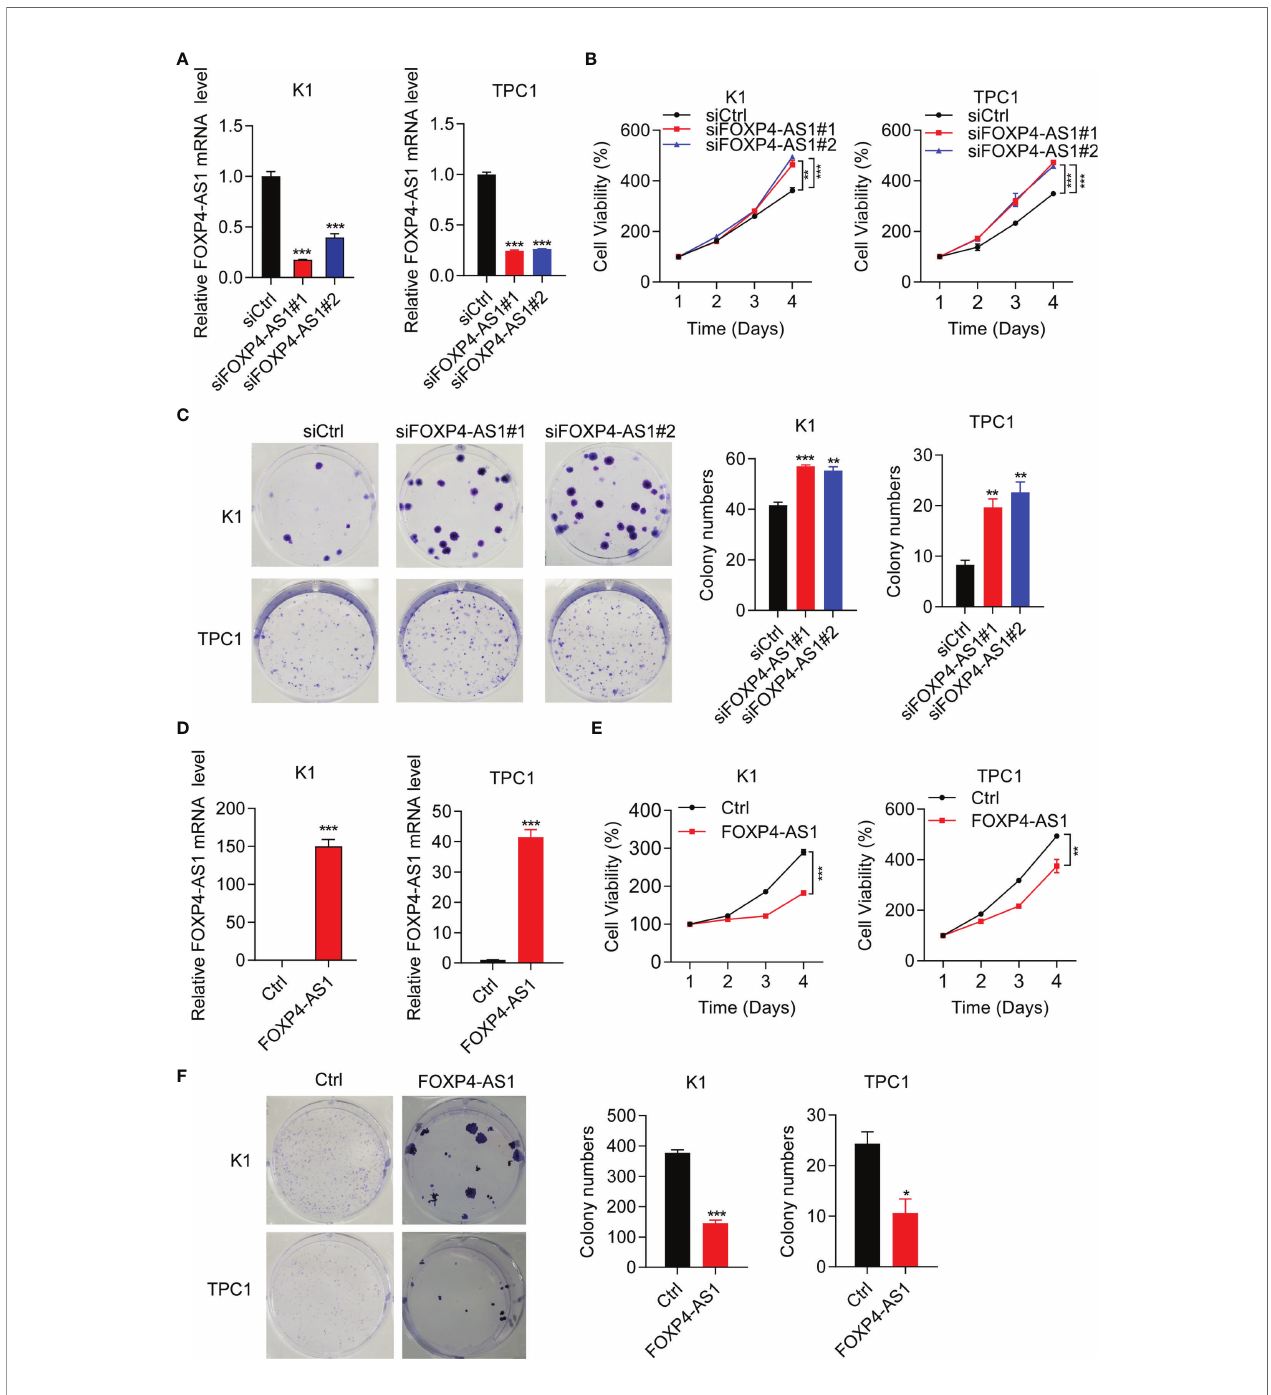
FIGURE 2 | FOXP4-AS1 inhibits papillary thyroid carcinoma cell proliferation. (A) Knockdown ef fi ciency examined in K1 and TPC1 cell lines of siFOXP4-AS1. (B) Cell viability of two PTC lines transfected with siFOXP4-AS1 was determined by CCK-8 assay. (C) Cell colony numbers of two PTC lines transfected with siFOXP4-AS1 were recorded by cell colony formation assay. (D) Overexpression ef fi ciency of FOXP4-AS1 in K1 and TPC1 cells. (E) Cell viability of two PTC cell lines transfected using FOXP4-AS1 was determined by CCK-8 assay. (F) Cell colony numbers of two PTC cell lines transfected using FOXP4-AS1 was calculated by cell colony formation assay. * p < 0.05, ** p < 0.01, *** p <